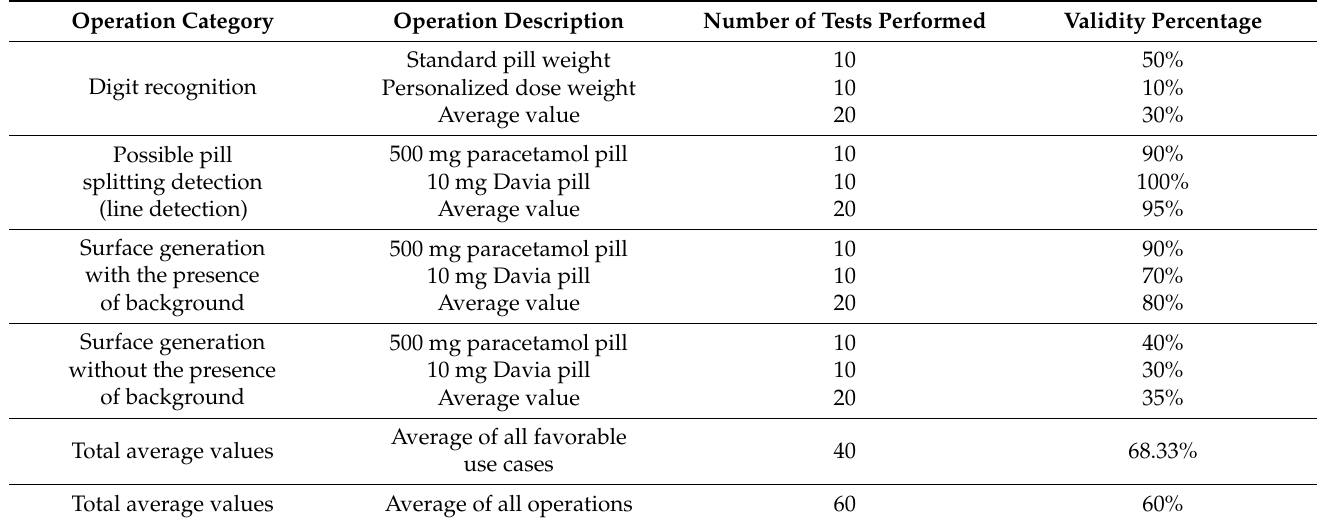
Table 1 illustrates the centralization of the above-mentioned percentage results. Table 1. Results of the performed